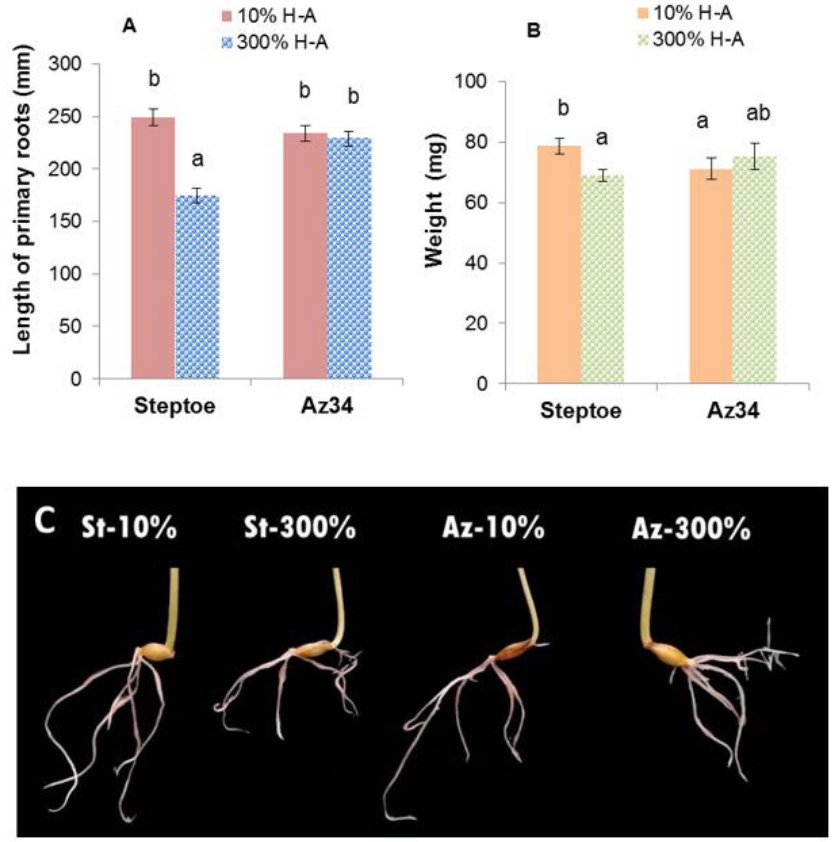
Figure 1. Total length of primary roots ( A ), weight ( B ), and root image ( C ) of 8-day-old barley wild type (Steptoe) and its ABA-deficient mutant (Az34) growing at 10% of supra-optimal (300%) Hoagland-Arnon solution (H-A). Means ± SE are presented. Statistically different means (n = 20) are indicated by different letters ( p < 0.05, ANOVA, Duncan’s